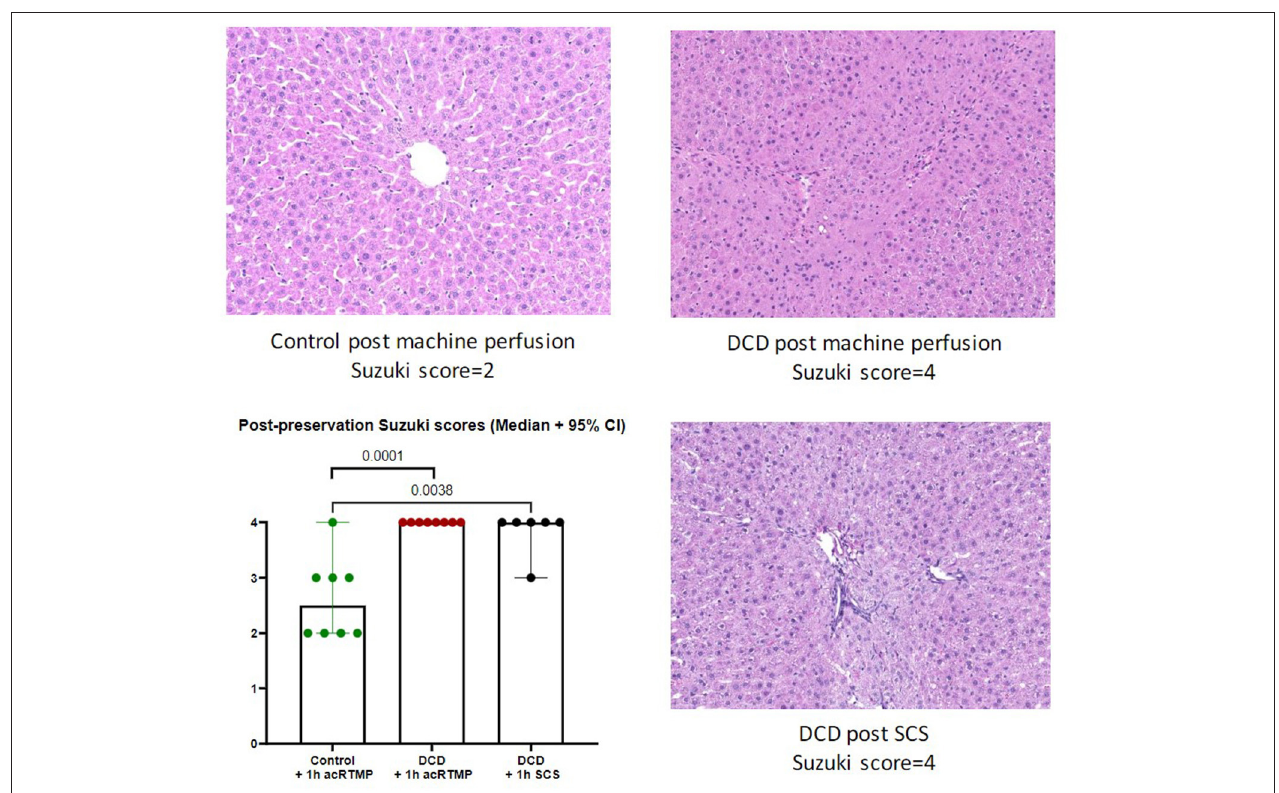
FIGURE 5 | Graft histologic injury by Suzuki score following preservation by SCS vs.